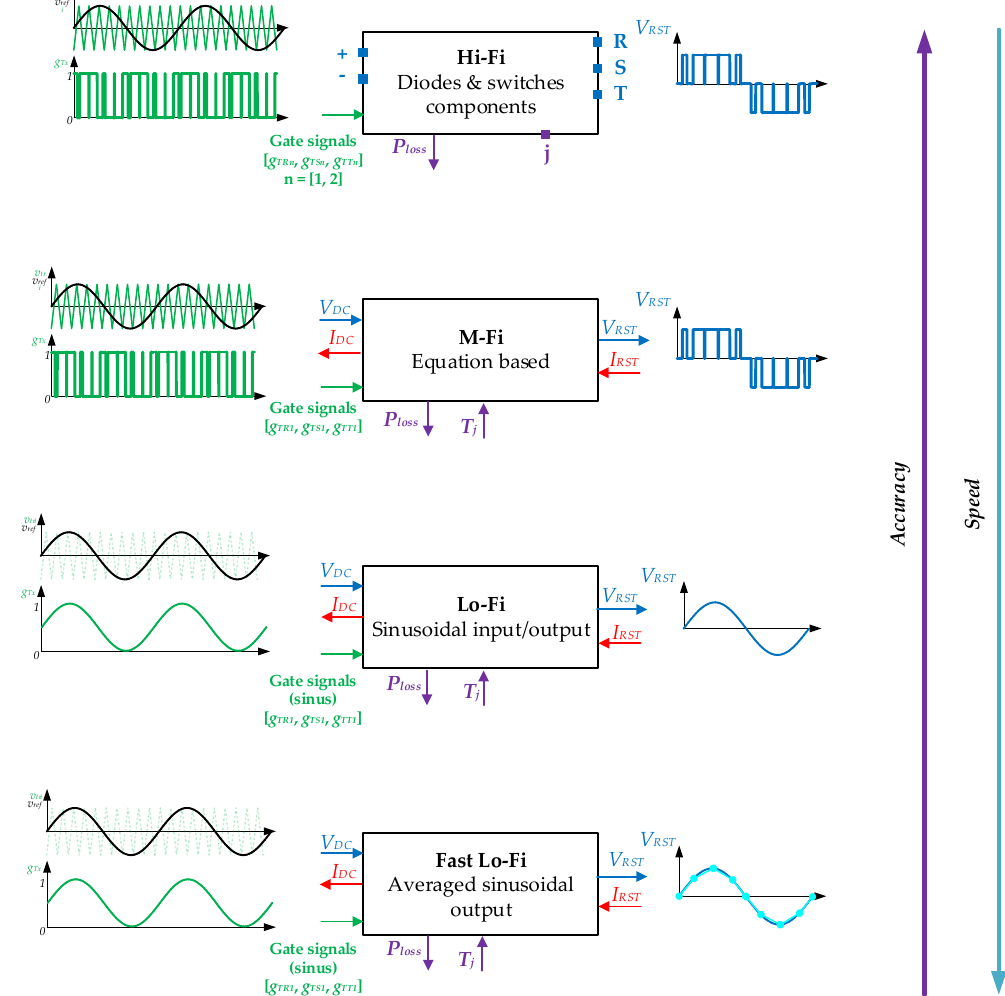
Figure 9. Model simplification resume scheme, presented in order of decreasing accuracy and increasing speed. Four different models have been developed.